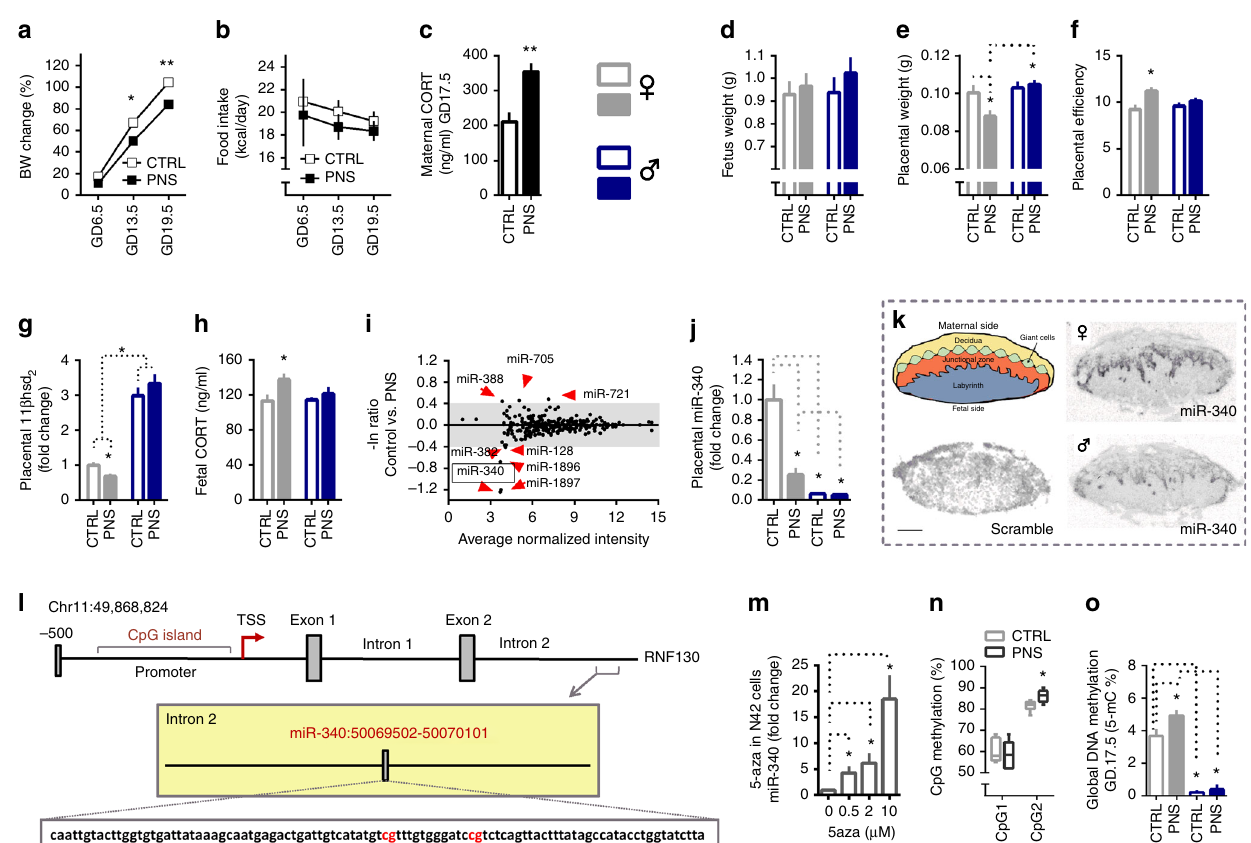
Fig. 2 Prenatal stress (PNS) downregulates placental miR-340 through gene body DNA methylation. a , b PNS affected the pregnant dams ’ body weight (BW) (repeated measures ANOVA F (1,9) = 21.56, p < 0.0001) without affecting food intake ( N = 5 – 6). c PNS increased maternal corticosterone (CORT) ( t (10) = 3.88, p = 0.003). d − f Fetus weight was similar in control and PNS offspring ( d ), but placental weight was reduced by PNS only in females (two- way ANOVA F int(1,18) = 4.54, p = 0.047) ( e ), resulting in increased placental ef fi ciency (Kruskal − Wallis H = 11.82, p = 0.008, speci fi c groups comparisons based on Mann − Whitney) ( f ). g − h Placental 11 β hsd 2 was overall higher in males (two-way ANOVA F (1,46) = 188.59, p = 0.000) but was reduced by PNS only in females (interaction effect F (1,46) = 5.85, p = 0.020, N = 11 − 12, from 5,6 different dams) ( g ) resulting in high fetal CORT in PNS females ( F sex(1,24) = 5.28, p = 0.032, N = 12) ( h ). i The placental miRNA array performed on females revealed downregulation of miR-340 by PNS. j MiR-340 validation showed reduced levels in PNS females and males of both prenatal conditions (two-way ANOVA F sex(1,41) = 41.00, p < 0.0001) and ( F prenatal (1,41) = 6.51, p = 0.015). k MiR-340 is expressed in the junctional zone of the placenta. l Schematic representation of the Rnf130 gene and CpG areas analyzed. m 5-aza treatment of N42 cells at increasing concentrations upregulated miR-340 levels (one-way ANOVA F (3,15) = 18.79, p < 0.0001, with Bonferroni post-hoc tests). n CpGs on the miR-340 sequence were highly methylated and CpG 2 was signi fi cantly more methylated in PNS female placentas (Mann – Whitney U = 3.50, Z = − 2.35, p = 0.015). Data are presented in min. to max. o Global DNA methylation differed dramatically among the groups (Kruskal − Wallis H = 18.31, p = 0.000). Females showed higher global methylation than males, an effect increased even further by PNS ( N = 6, from 5 to 6 different dams). Signi fi cance between groups and sexes based on Tukey ’ s multiple comparison tests and Mann − Whitney post-hocs when relevant. GD gestation day, CTRL Control. Data are presented in mean and s.e.m. Scale bar: 1 percentages of animals being prone to ABA as a result of miR- 340 OE (Fig. 6j).